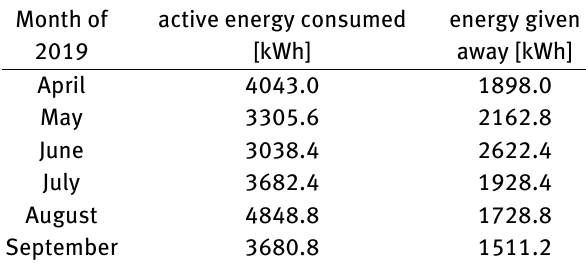
Table 1: Active energy consumed and energy given away in